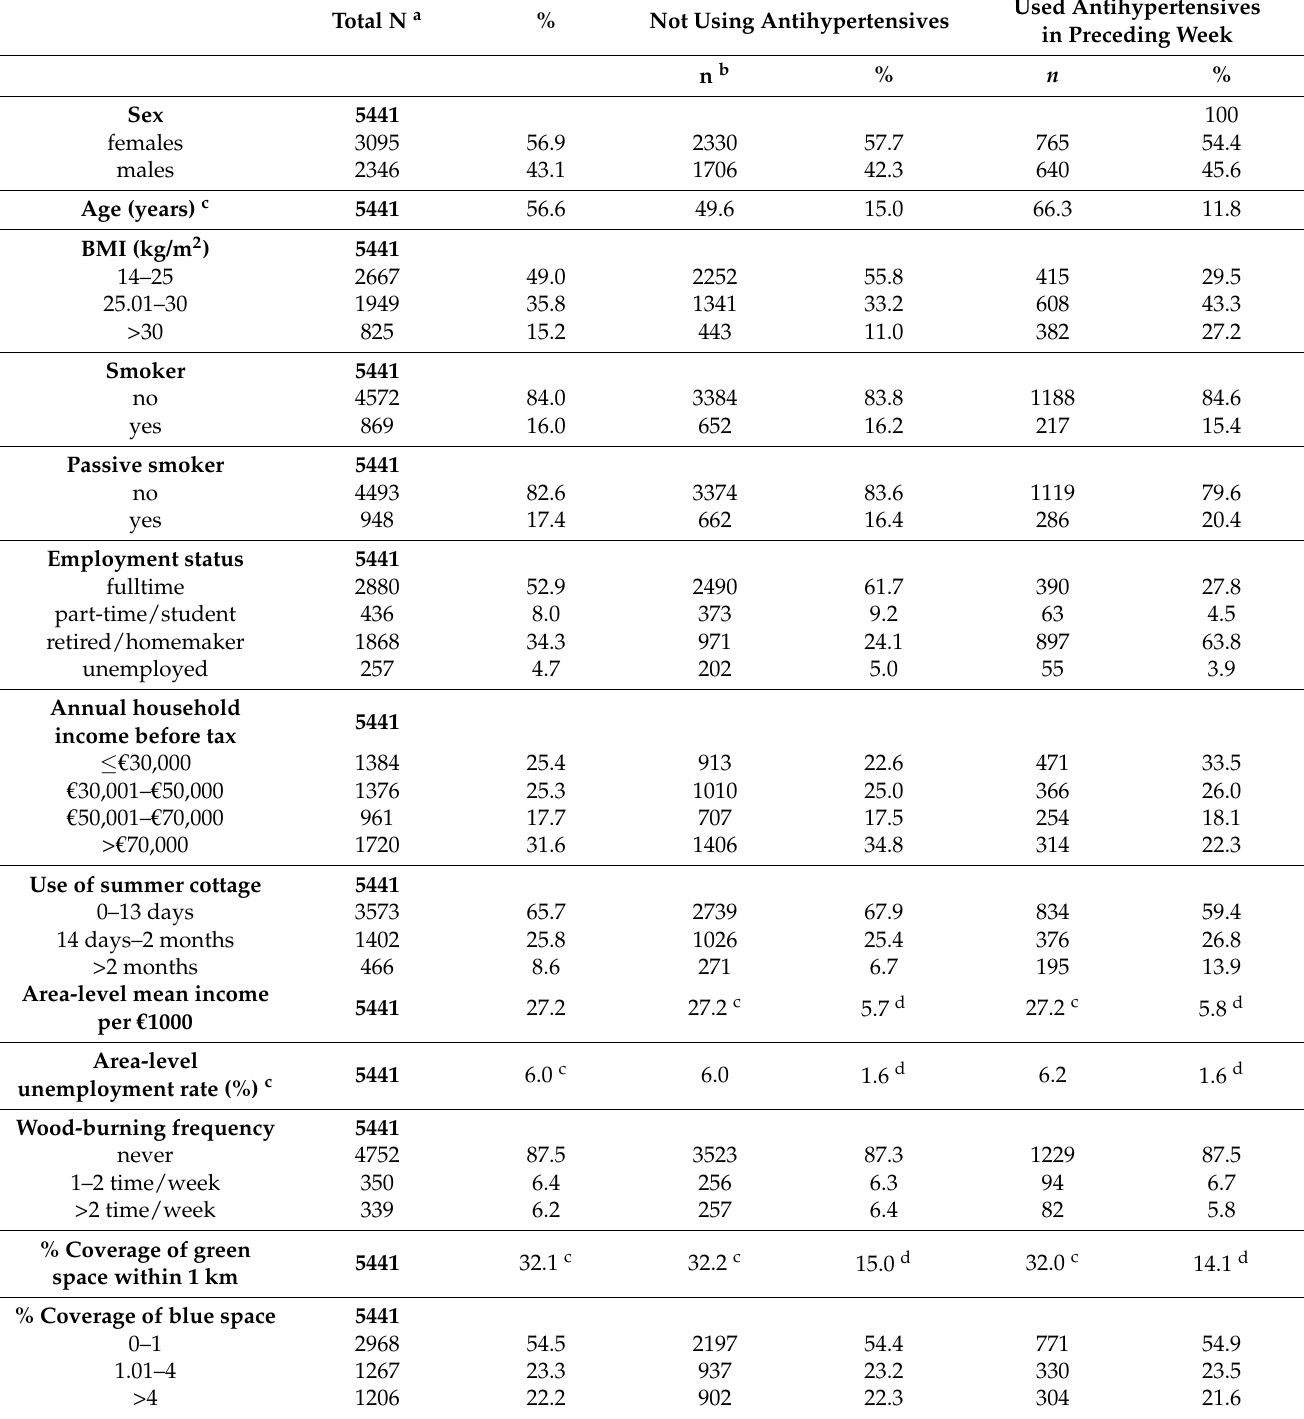
Table 1. Descriptive data of study